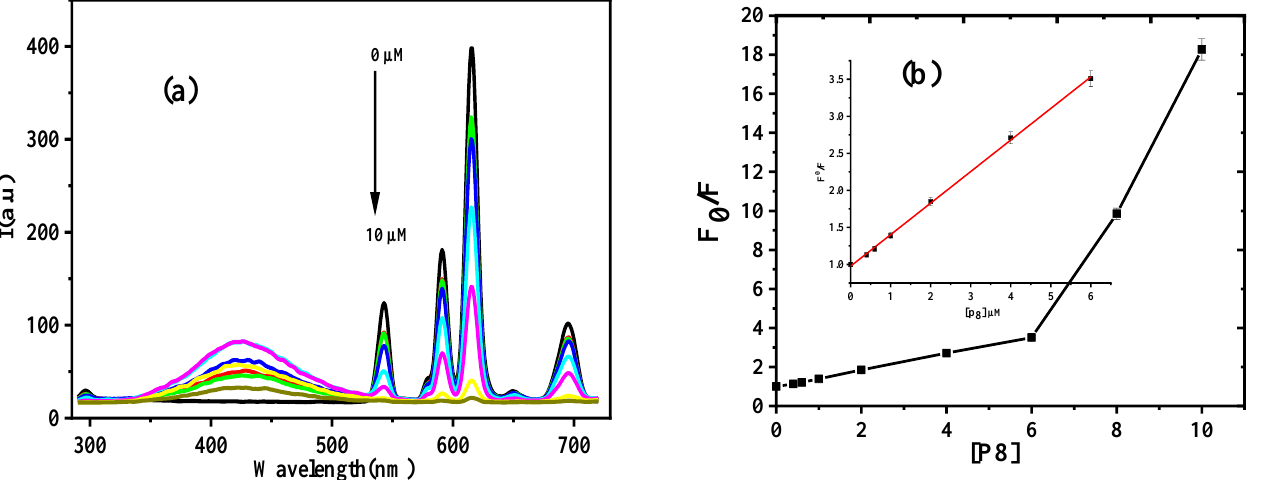
Figure 7. The luminescence spectra and calibration plot of the 2.5 × 10 −5 mol. L −1 of Eu (III) – complex with different concentrations of malathion (p8) (0, 0.4, 0.6, 1, 2, 4, 6, 8, and 10 µM) in methanol, at λ ex = 268 nm and room temperature.